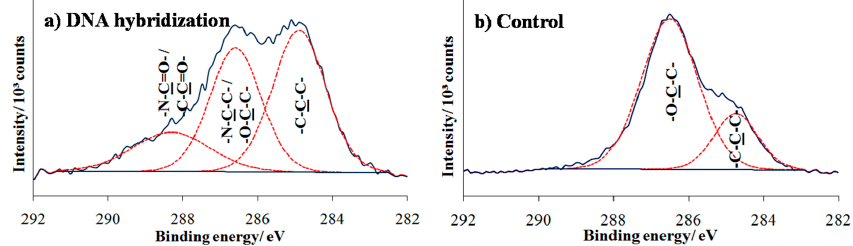
Figure 7. High resolution of C 1s XPS spectra for ( a ) DNA hybridization on photo-oxidized sample and ( b ) control sample.